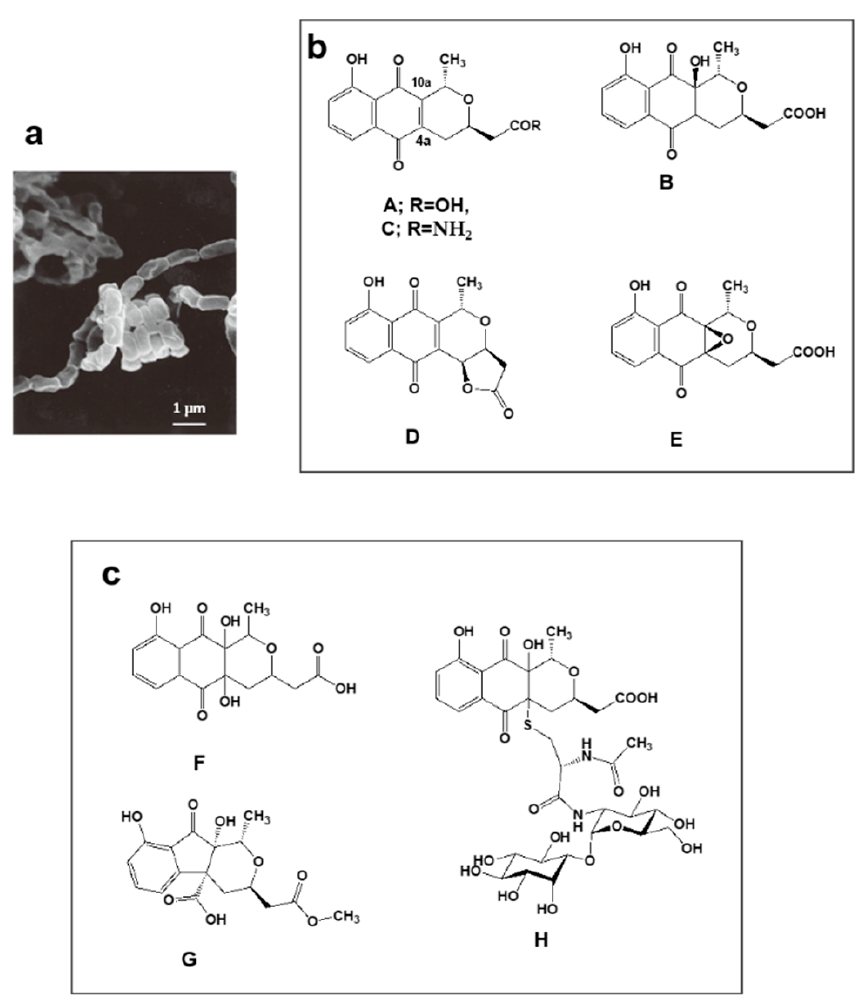
Figure 2. Nanaomycin-producing strain “ Streptomyces rosa subsp. notoensis ” OS-3966 and new analogs discovered by PC screening from a culture broth. ( a ) Scanning electron micrograph of aerial spore chain of “ S. rosa subsp. notoensis ” OS-3966 grown on agar medium; ( b ) Nanaomycins A–E discovered as antibacterial and antifungal substances during 1974–1979; ( c ) New analogs (F–H) discovered from the culture broth via PC screening.